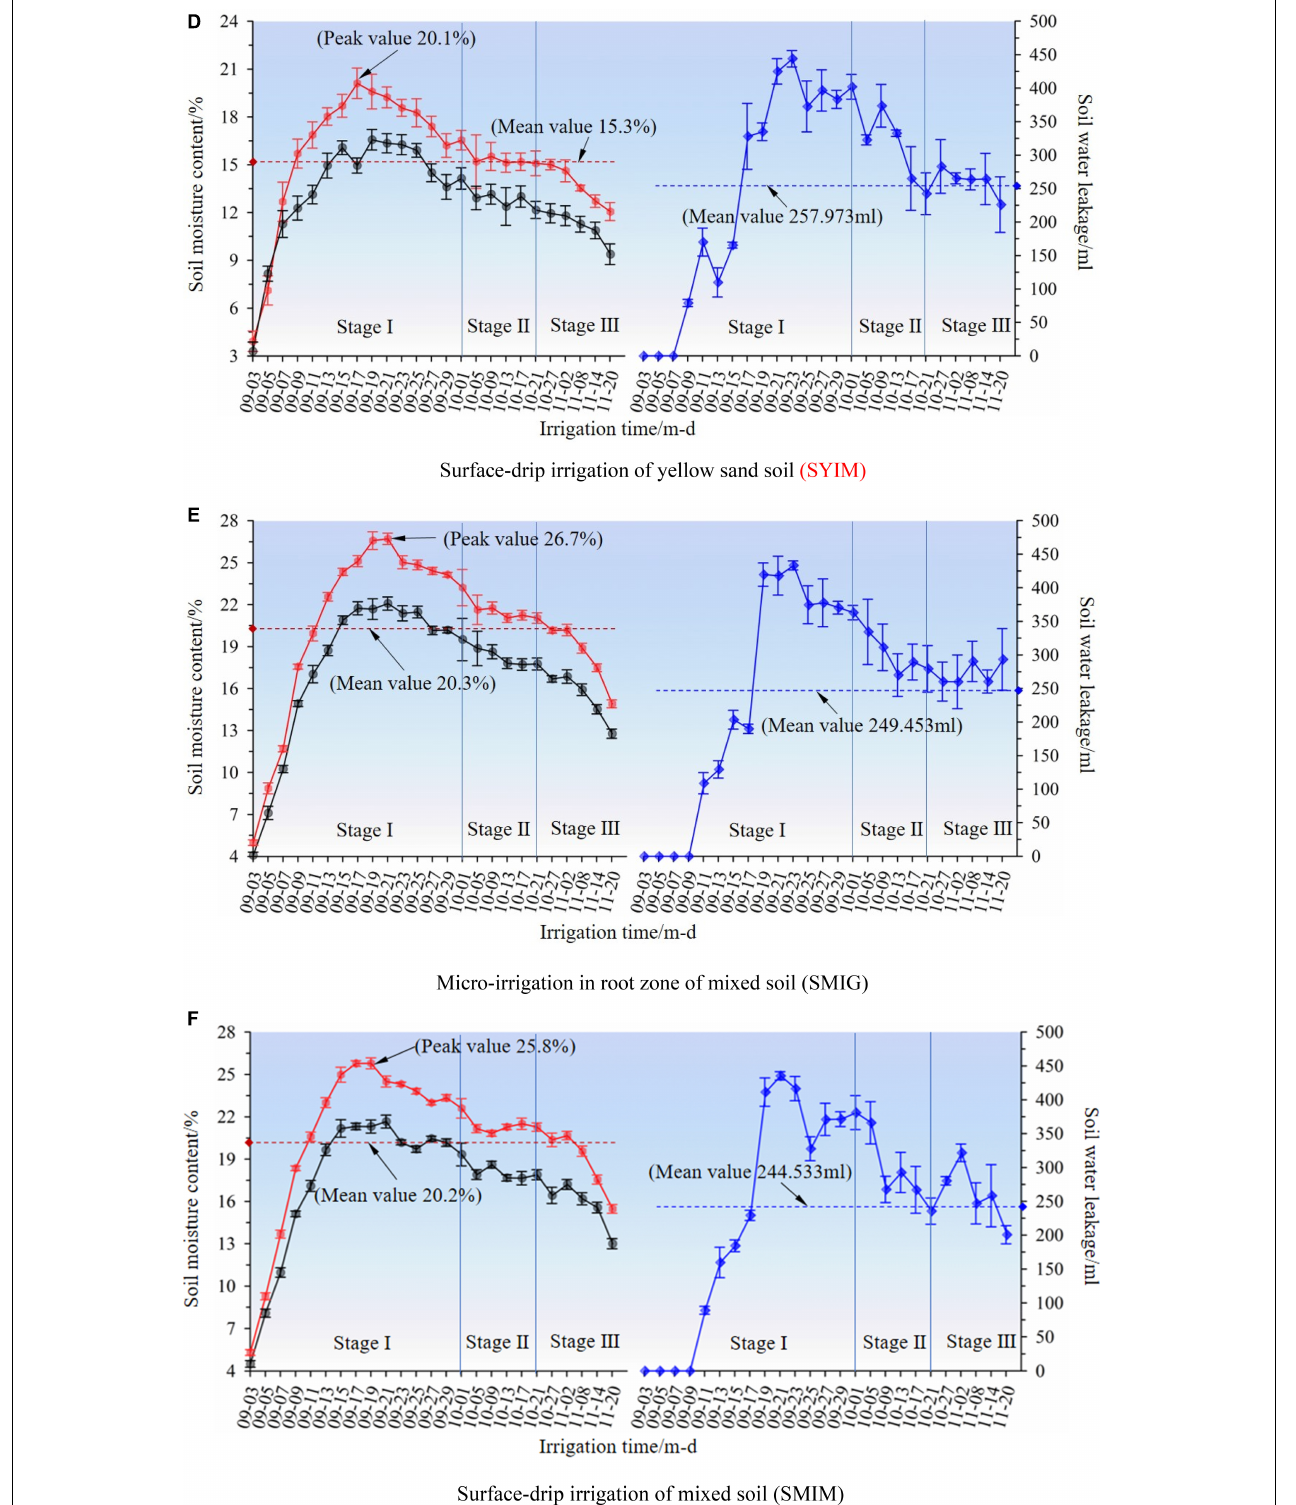
FIGURE 4 | Variation map of moisture content (TDR and weighing method) and water drainage of non-crop soil against time. represents moisture meter method, represents weighing method, represents amount of soil water leakage. Stages I, II, and III represents three time-interval gradients, i.e., 2, 4, and 6 days,